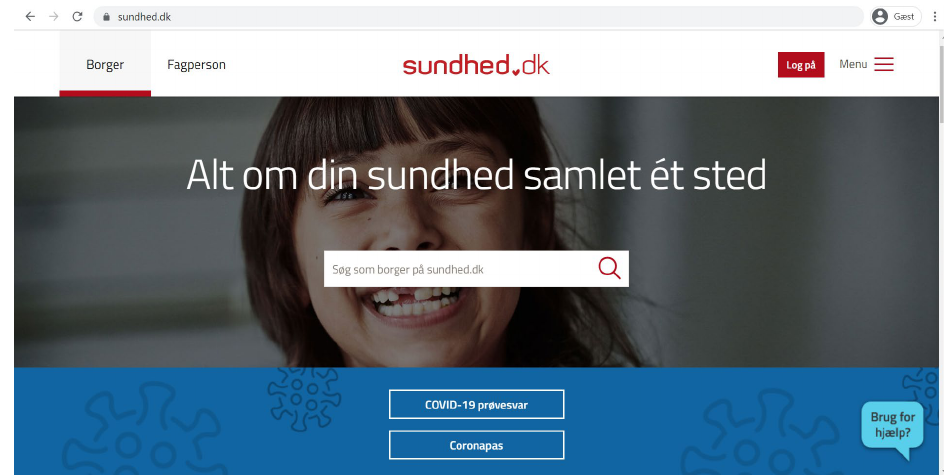
Figure 2 . Front page on Sundhed.dk. The headline reads: ‘Everything about your health in one place’. Source: